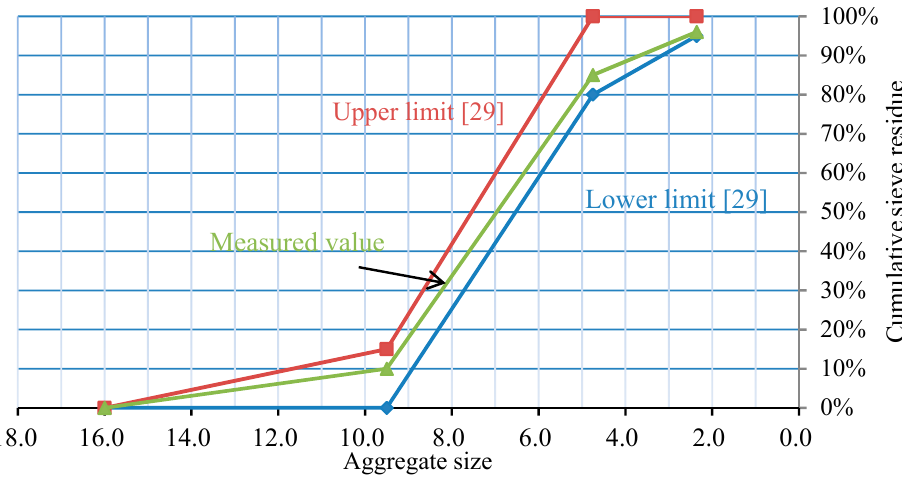
Figure 2. Particle size distribution curve of the coarse aggregate in RCA. Table 1. Experimental parameters of first group.